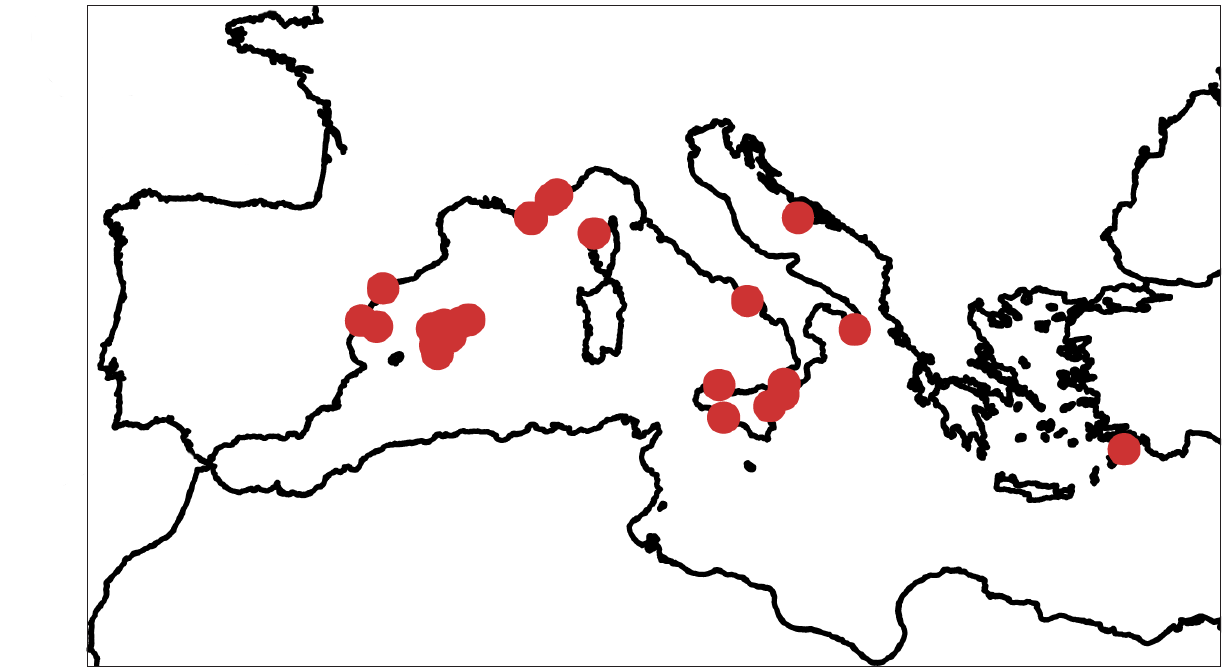
Fig. 4. Recorded sites of Acrodiscus vidovichii (Menegh.) Zanardini along the shores of the Mediterranean